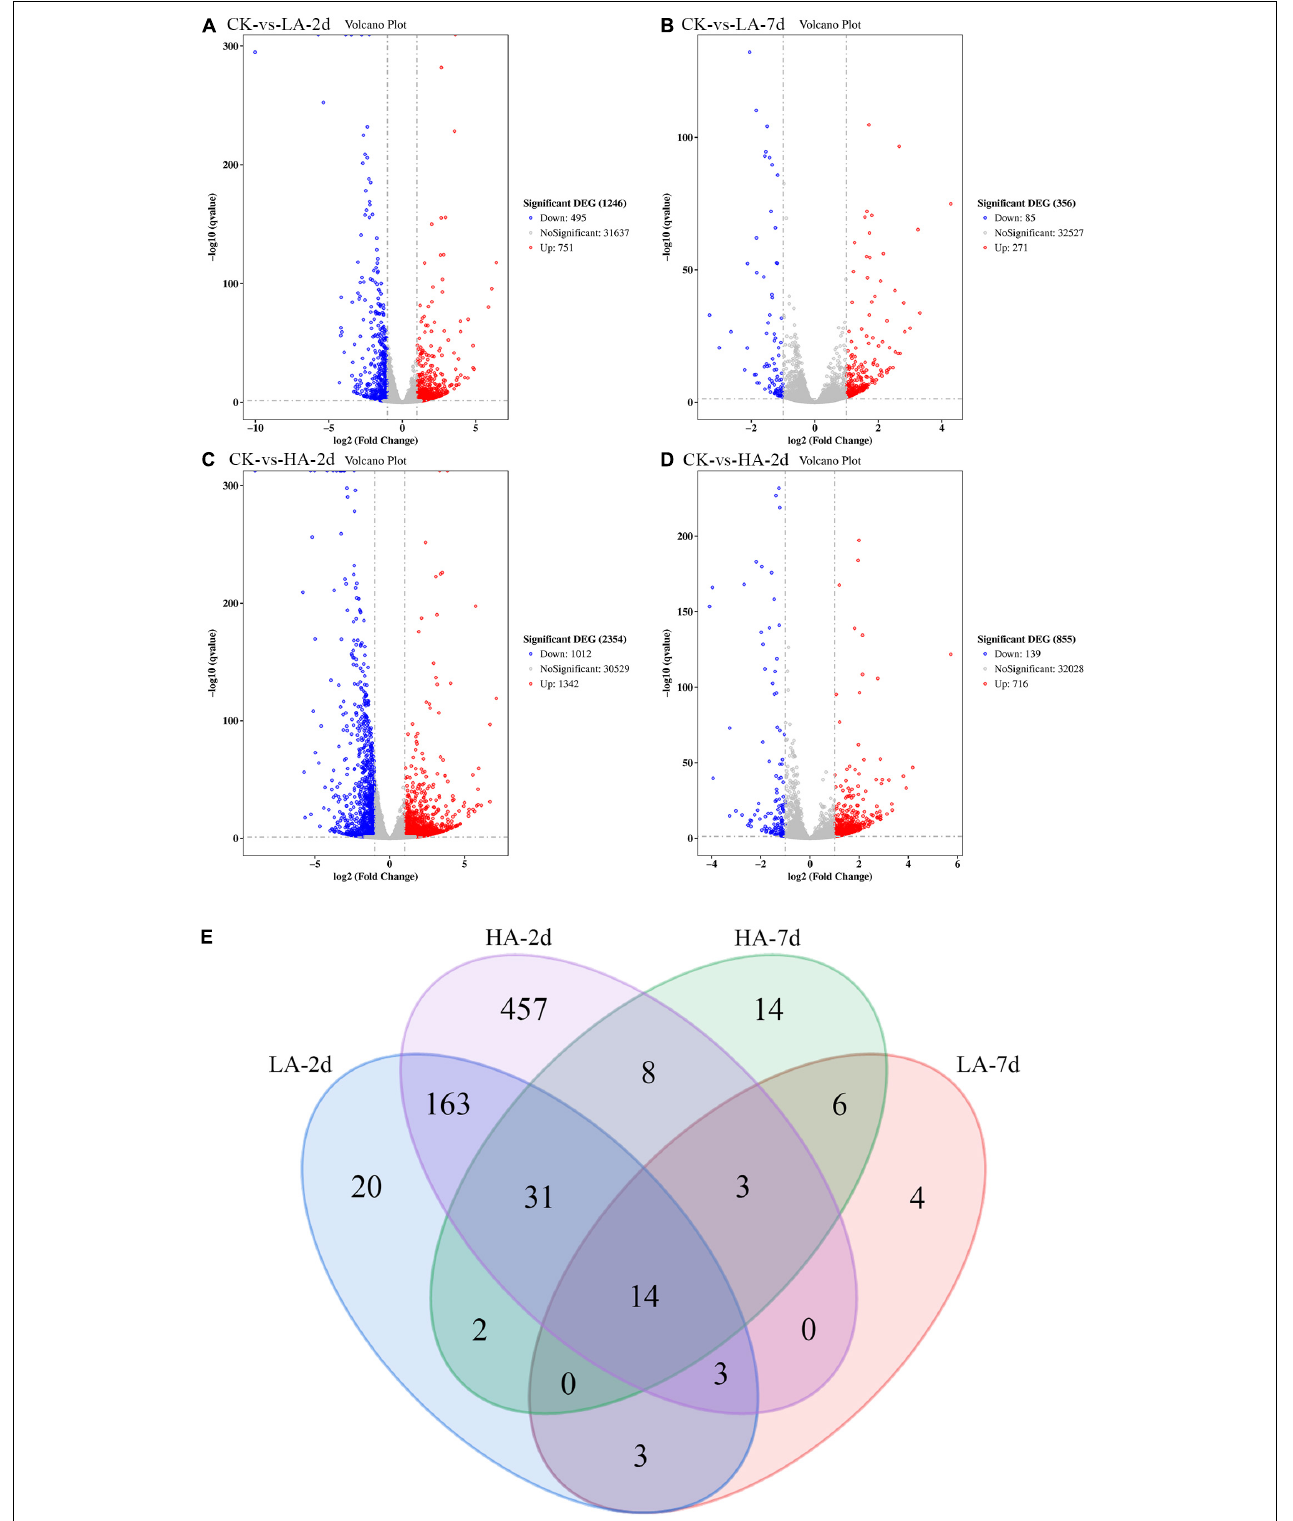
FIGURE 5 | The Volcano plot and Venn diagram of DGEs. (A–D) Red spots indicate significantly up-regulated genes; blue spots indicate significantly down-regulated genes; gray spots are genes of no differential expression. The horizontal line at false discovery rate (FDR) = 0.05; vertical line at | log2FC| = 1. (E) There were special DEGs in the different analyses of each group (Venn diagram, FDR ≤ 0.01 and | log2FC| ≥ 2).